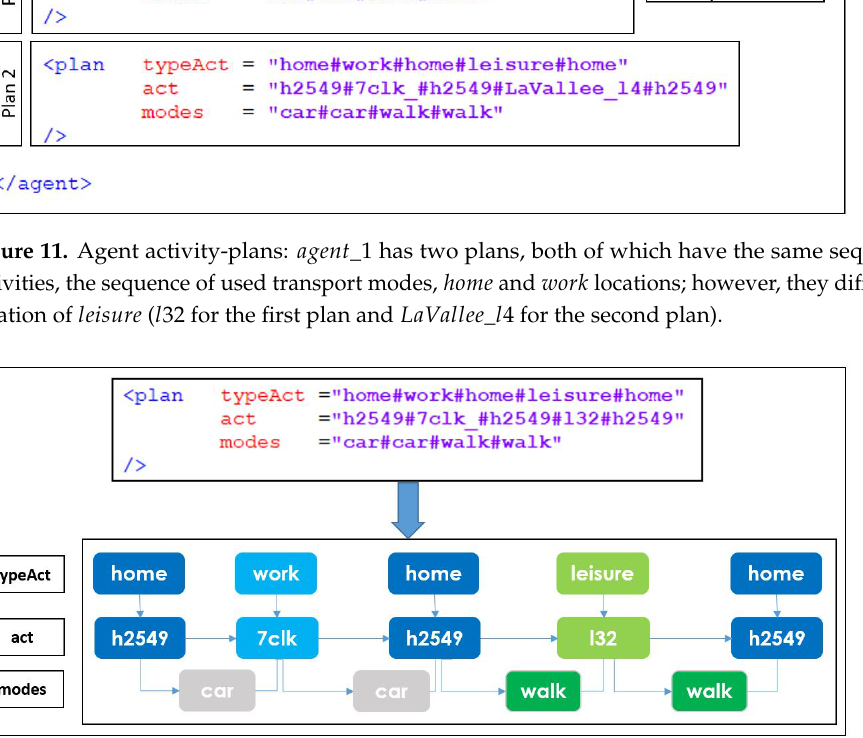
Figure 12. Activity-plan: the first plan of the agent _1 is detailed, the sequence of activities is home → work → home → leisure → home . The locations of activities are: h 2549 ( home ) , 7 clk ( work ) and l 23 ( leisure ) . The transport modes are: car for trips home ↔ work and walk for trips home ↔ leisure